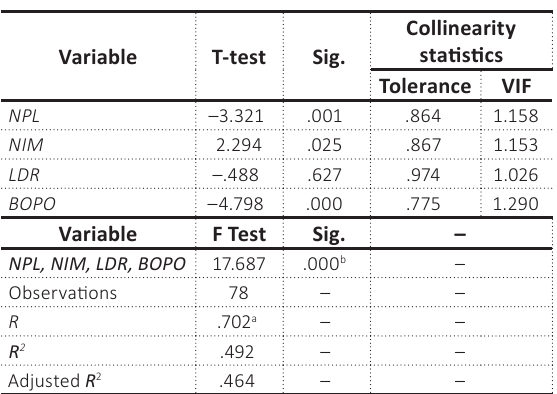
Table 3. Regression result on the impact of NPL, NIM, LDR and BOPO on ROA of BPD banks